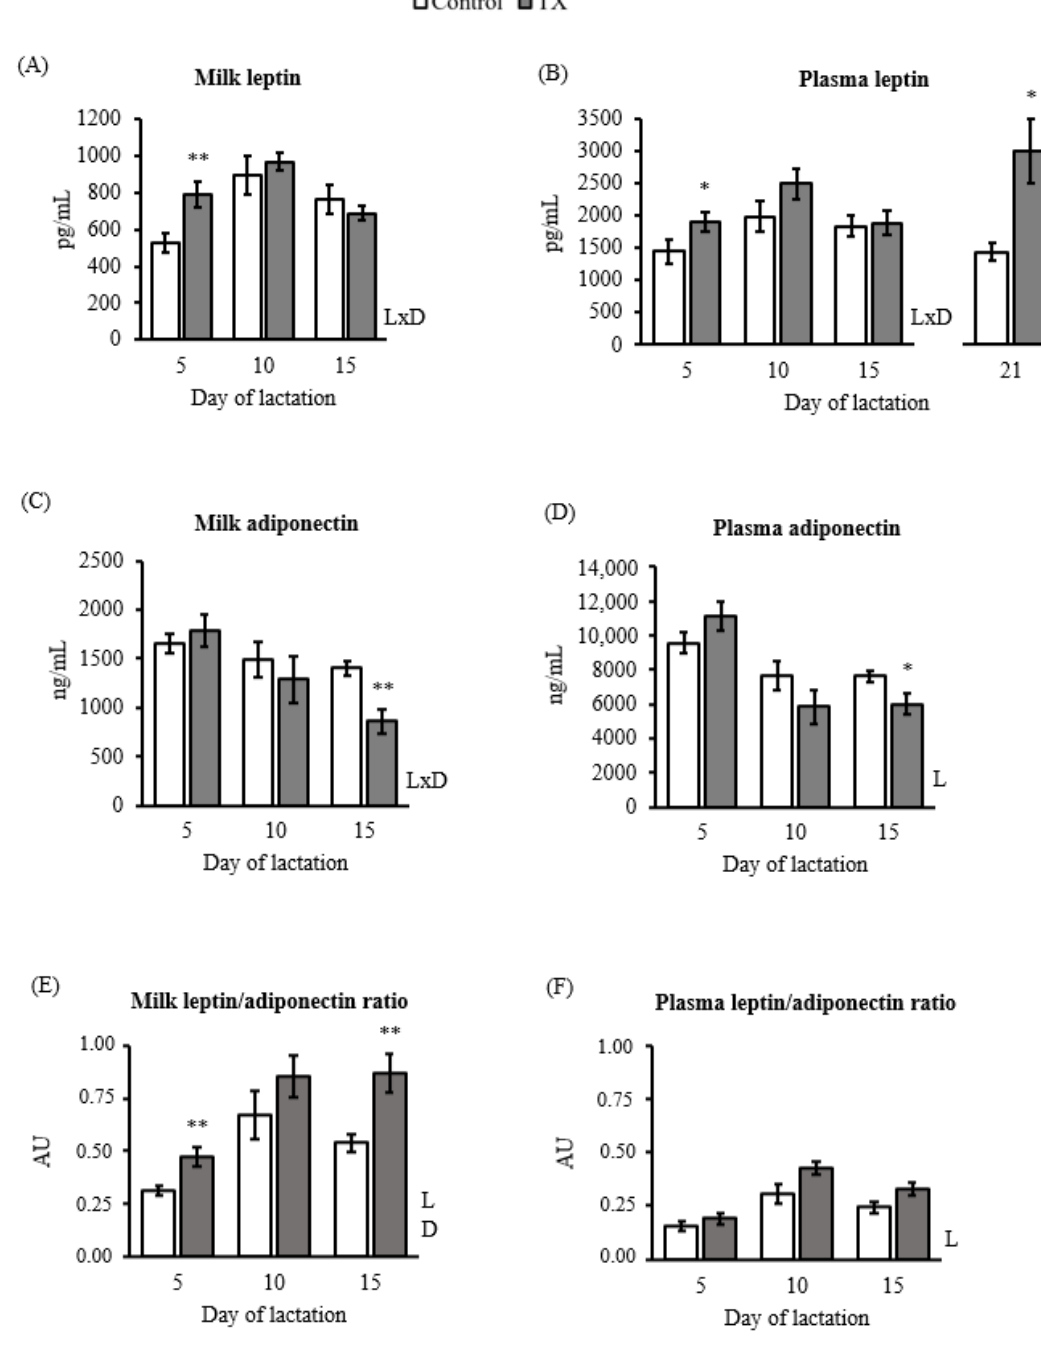
Figure 2. Leptin and adiponectin levels throughout lactation. Leptin concentration during lactation in milk ( A ) and plasma was obtained from a saphenous vein ( B ) (on day 5, 10, and 15 of lactation) and trunkal blood (on day 21). Adiponectin levels at days 5, 10, and 15 of the suckling period in milk ( C ) and plasma ( D ) were obtained from the saphenous vein. The Leptin/Adiponectin (L/A) ratio in milk ( E ) and plasma ( F ). Data are mean ± SEM ( n = 7). Statistics: A repeated measures ANOVA was carried out to study the effect of maternal diet and day of lactation: L, effect of the lactation day; D, the effect of TX diet; and LxD interaction between lactation day and TX diet. Single comparisons between groups were performed by Student’s t -test: *, different from controls. Threshold significance was set at p ≤ 0.05 for all tests (**, p ≤